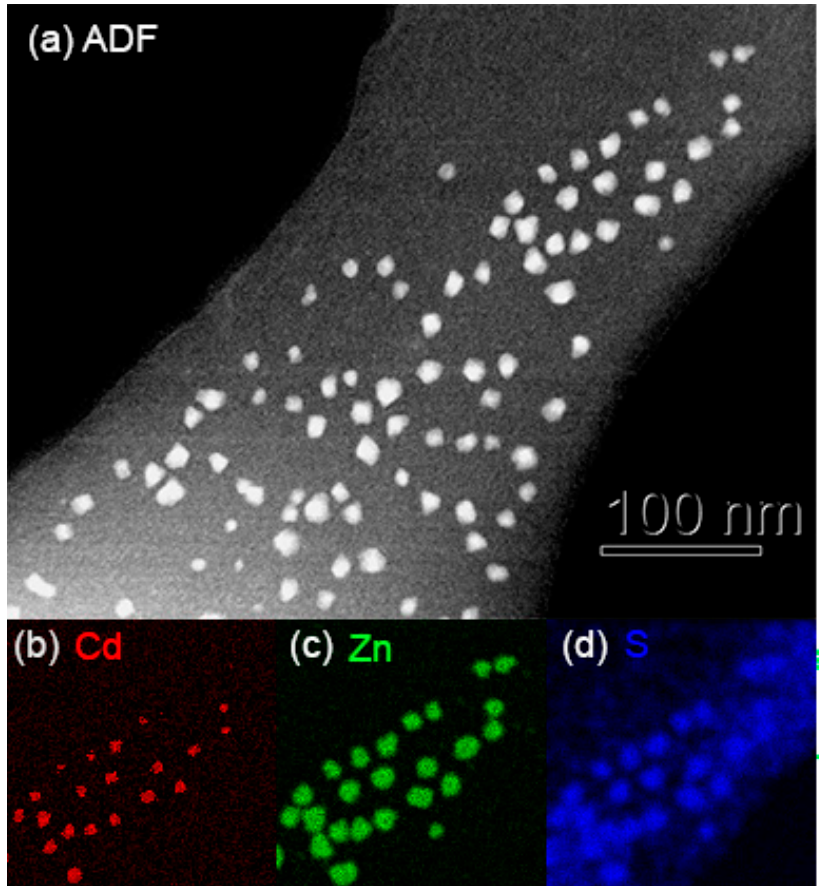
Figure 2. Example of CdZnS colloidal quantum dots with CdS core/ZnS shell structure ( a ) annular dark-field scanning TEM (ADF-STEM) image of a larger region and ( b–d ) X-ray maps of the top right quarter of ( a ) ~180 nm wide, displaying intensities of ( b ) Cd L (max = 13 counts), Zn K (max = 63 counts) and S K (max = 58 counts). The weak sulphur background signal in ( d ) is an artefact due to imperfect background subtraction for the sulphur K-edge at 2.3 keV; also, it suffers from tails of the neighbouring silicon K-edge at 1.8 keV as the supporting carbon film actually contained some silicon. Nanomaterials 2019 , 9 , x FOR PEER REVIEW